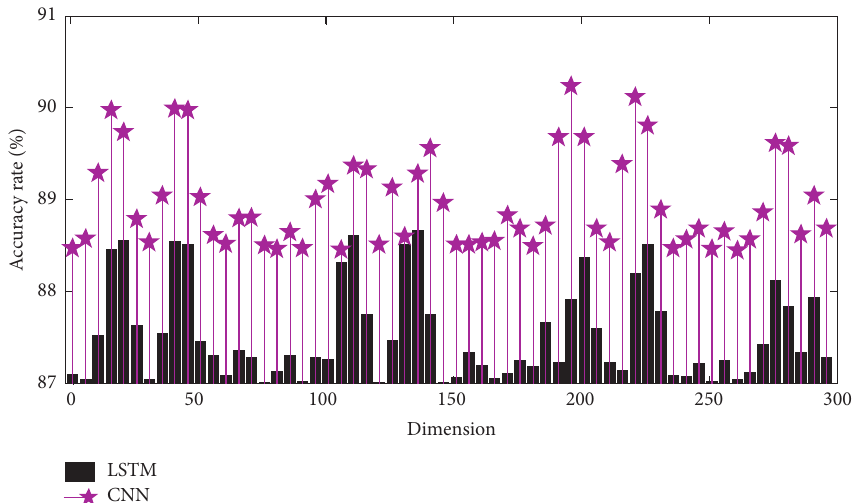
Figure 6: GloVe word vector detection level F 1 result in crossvalidation.